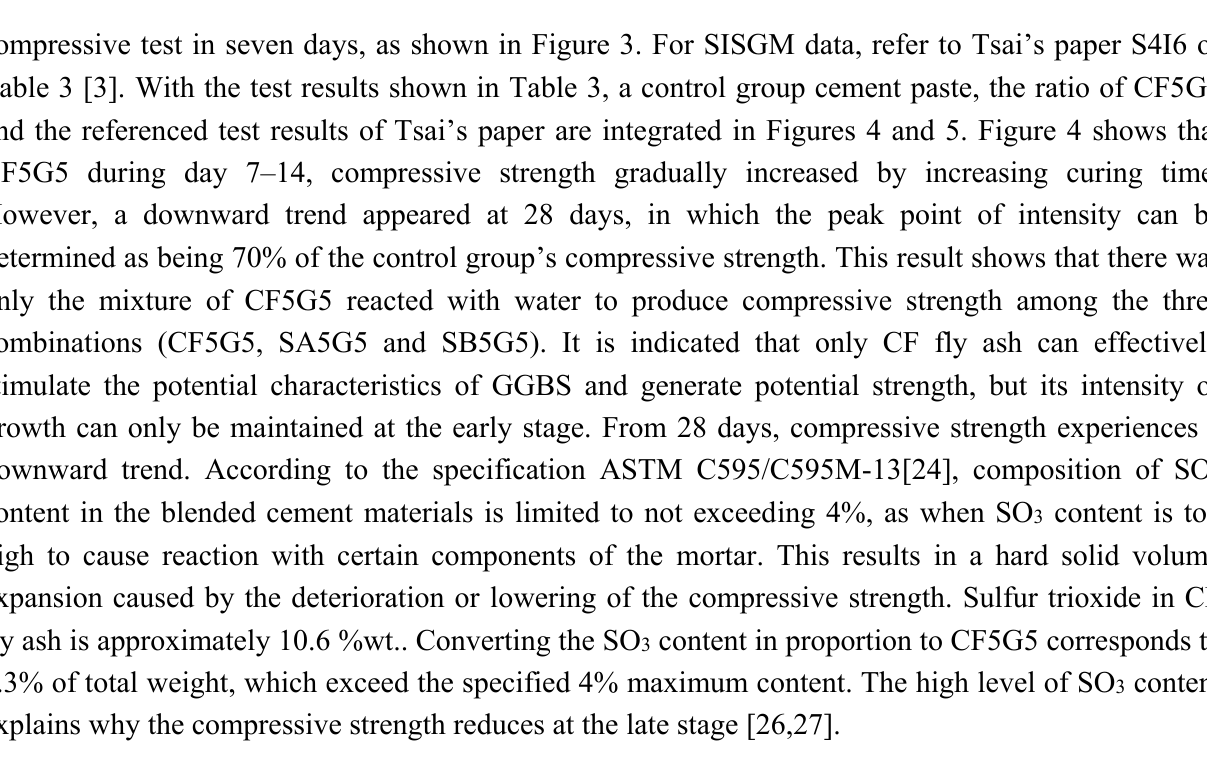
Table 3. Compressive strength results,